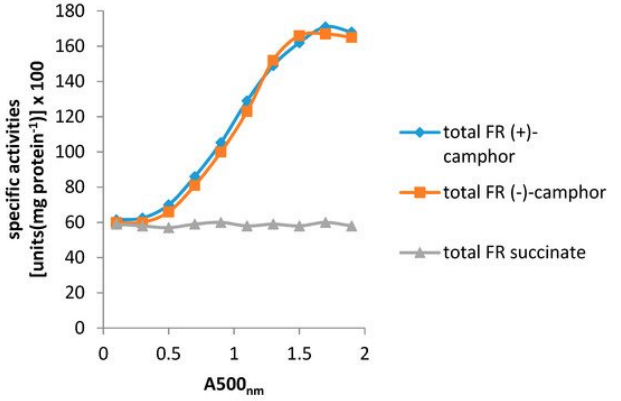
Figure 10. Specific activity of total flavin reductase (FR) throughout the growth of P. putida ATCC 17543 on either (+)-camphor, ( − )-camphor, or succinate as sole carbon source. Attention then focused on what other activities were responsible for the significantly up-regulated total camphor-induced reductase activity. This search then identified two principal additional camphor-induced reductase activities, both induced by growth on either terpene enantiomer. Perhaps not unsurprisingly, one of these was confirmed to be Fred, the 37 kDa homodimer reported previously as the sole reductase activity of P. putid a ATCC 17453 [44]. More unexpectedly, however, was that the purified monomeric protein responsible for the second additional camphor-induced flavin reductase activity had an N-terminal amino acid sequence consistent with that of putidaredoxin reductase (PdR), a 48.5 kDa protein coded for by the camA gene of the CAM plasmid, and known to serve in the role of an FAD reductase as one of the functioning components of camphor 5- monooxygenase [92], but which had not been reported previously to serve as an FMN reductase. Interestingly, the initiation codon GTG for camA is a rare start codon, and is thought to be important in the control of PdR abundance. Purified samples of Fred, Fpr1, Fpr2, and most significantly PdR, were then confirmed to be equally active in supporting lactonization reactions with a high degree of enantioselectivity by purified preparations of both DKCMOs. This previously unrecognised ability of PdR to serve a functional role in the redox flux that supports the DKCMOs has significant implications for the metabolic autonomy of the catabolic CAM plasmid of P. putida ATCC 17453 (vide infra). That four different identified reductases present in camphor-grown P. putida ATCC 17453 can serve effectively as distal sources of the requisite FMNH 2 for both of the DKCMOs confirms